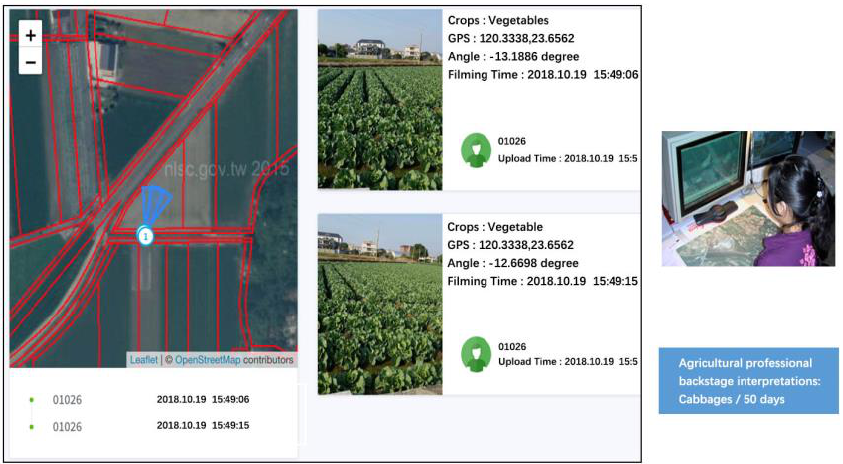
Figure 10. Backstage interpretations of the field survey images by an agricultural professional.